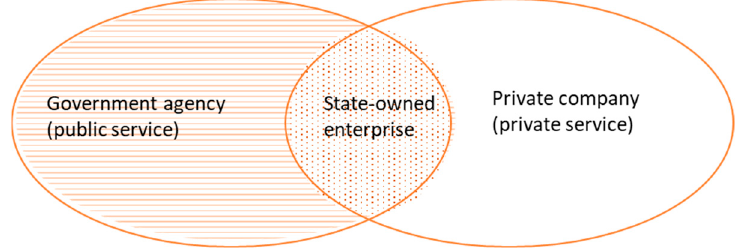
Figure 1. The SOE at a public-to-private organizational